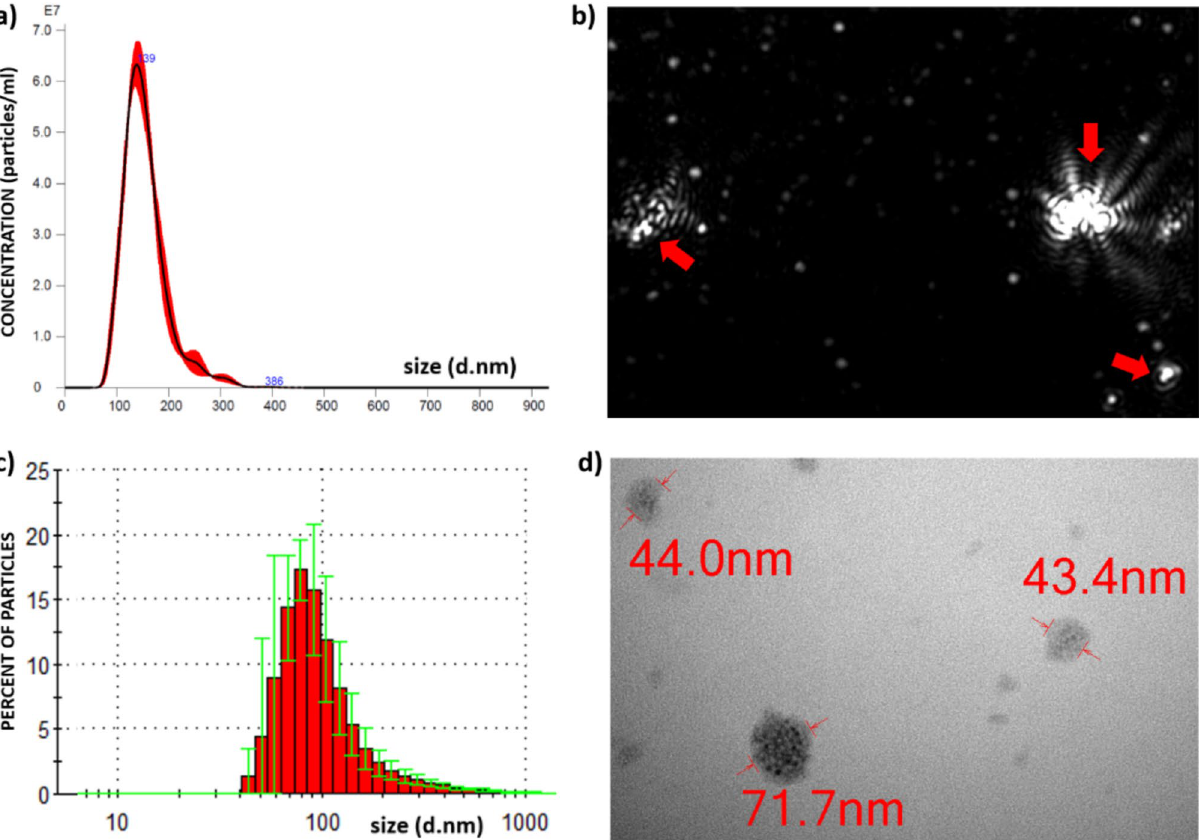
Figure 1. Slug EXs characterisation. ( a ) Representative histogram illustrating the nanoparticle size distribution of slug EXs in liquid suspension as determined by Nanoparticle tracking analysis. ( b ) Visualisation of the individual EXs (single white dots of various sizes) and their aggregates (red arrows) from a video recording of the particles moving under Brownian motion. ( c ) Representative histogram illustrating the size distribution of slug EXs as determined by Dynamic light scattering analysis. ( d ) Transmission electron micrographs of slug EXs showing vesicular